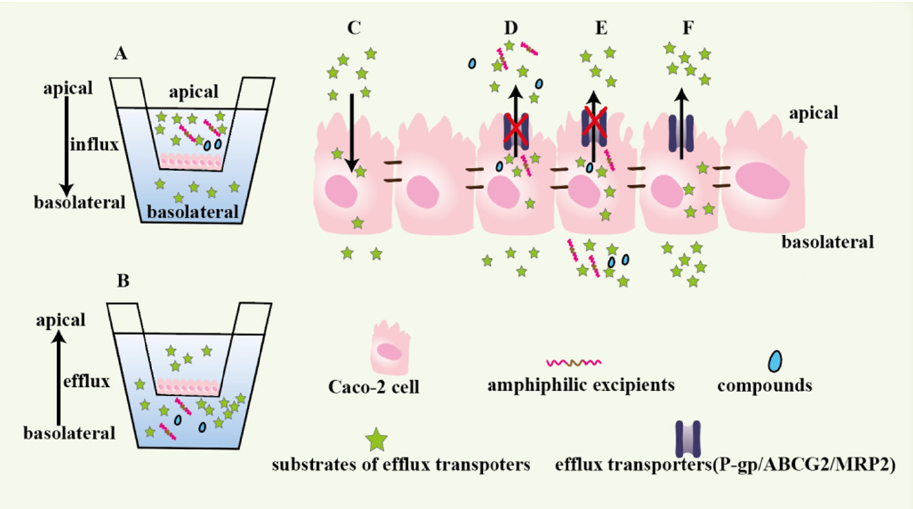
Figure 1. Caco-2 monolayers to evaluate the drug absorption and efflux and investigate functional excipients or inhibitors. A: the apical side is used as drugs donor to measure drugs absorption. B: the basolateral side used as drugs donor to research drugs efflux. C: drugs influx. D and E: studying whether compounds and excipients could prevent drugs from being pumped to the apical side of monolayer by efflux transporters. F: the drugs efflux mediated by efflux